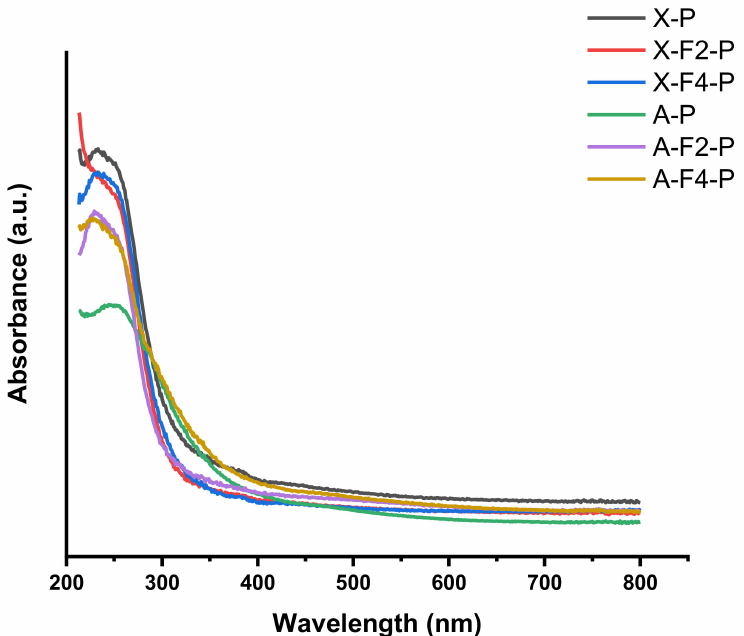
Figure 6. UV-Vis spectral data of samples generated during modification of fabrics.